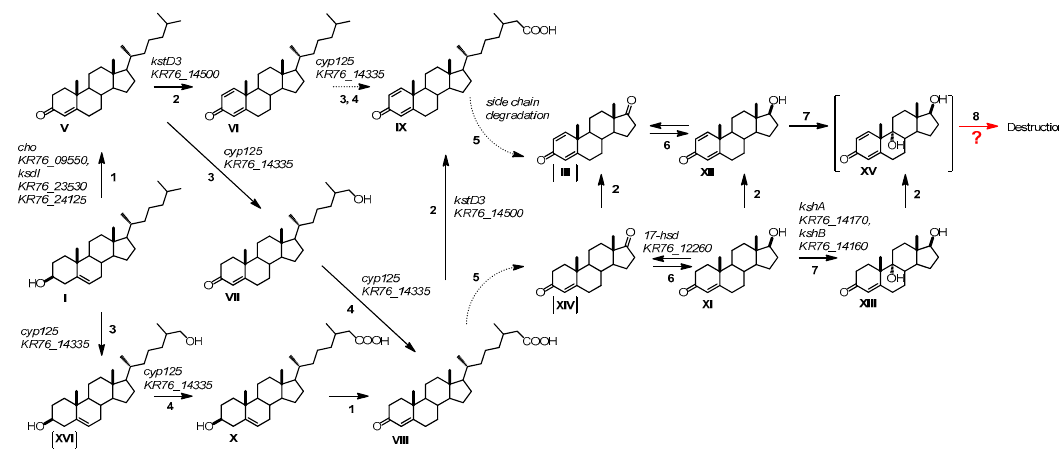
Figure 6. Cholesterol side chain oxidation by N. simplex VKM Ac-2033D. Substances: I -Cholesterol, V